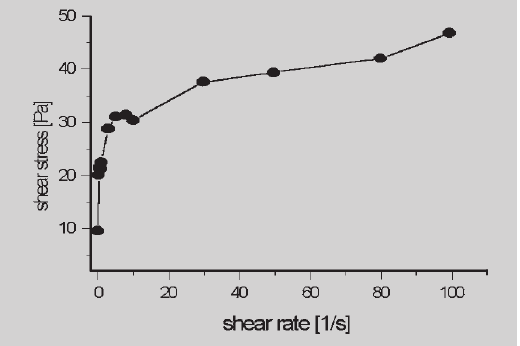
Figure 5 (left): The flow curve for a xantan solution (Non-Newtonian fluid). Figure 6 (right): The flow velocity profiles at cross section C for a xantan solution ( ∑ ) and for epoxy resin ( Ç